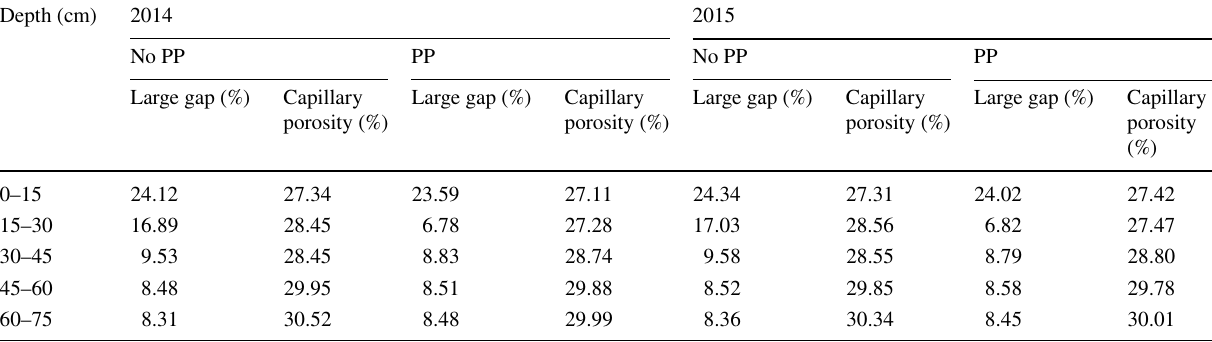
Table 4 Soil porosity with and without a plough pan (PP) Depth (cm)